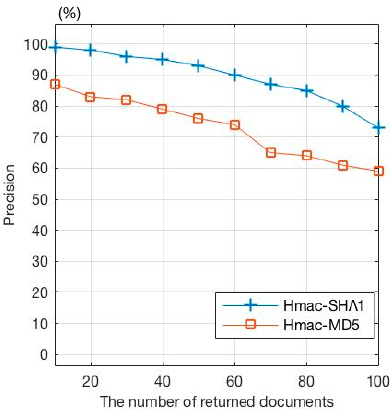
Figure 9. Evaluation of precision of search results.